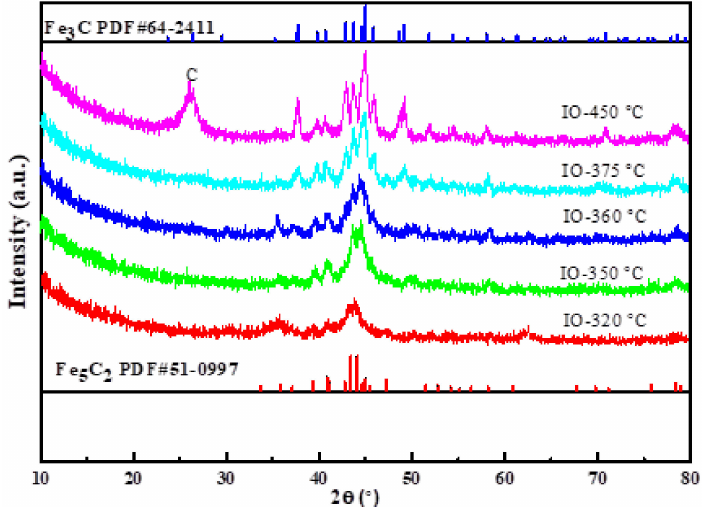
Figure 1. The X-ray di ff raction (XRD) patterns of the iron carbide catalysts treated at di ff erent carburization temperature